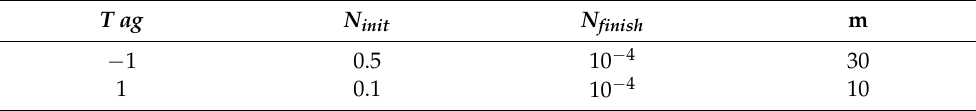
Table 1. Parameter selection of decision